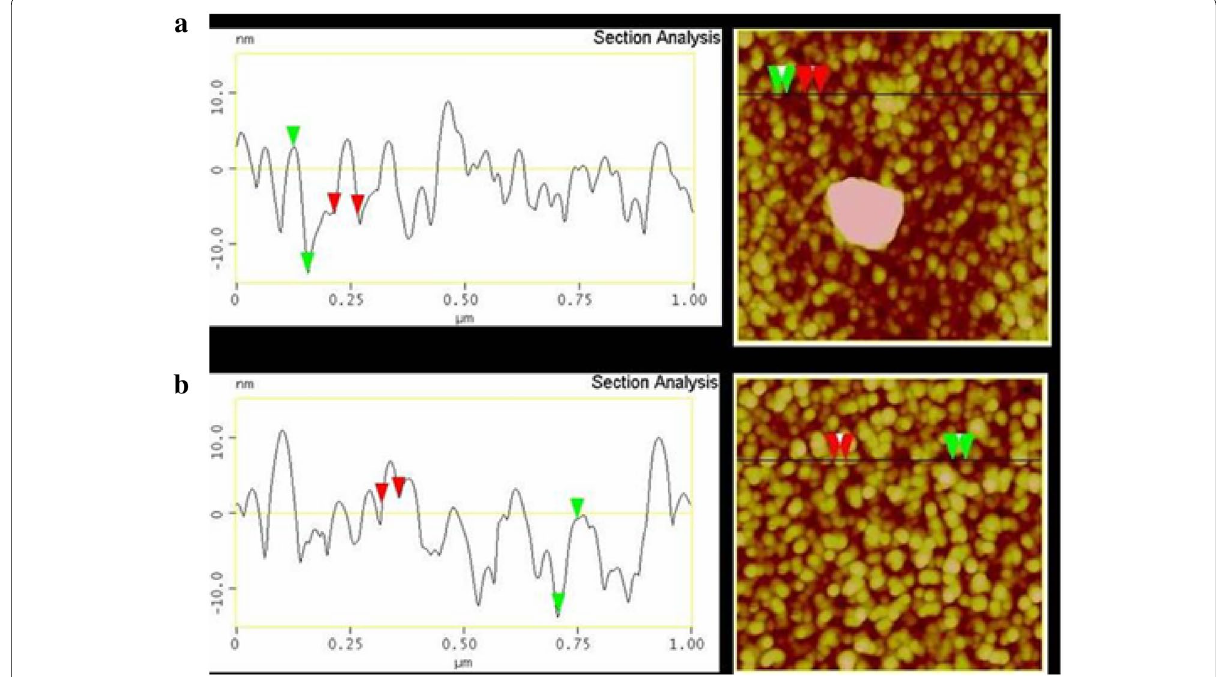
Fig. 1 AFM images of MP-nc-SiC ( a ), and HP-nc-SiC series films ( b